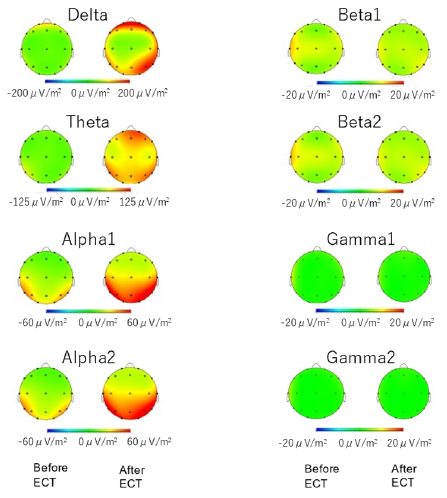
Figure 2. Grand average topographical plot of electroencephalography power in delta, theta, alpha 1, alpha 2, beta 1, beta 2, gamma 1, and gamma 2 for both time points (before and after electroconvulsive therapy (ECT)). In alpha 1 and alpha 2, the electrodes O1, O2, P3, P4, T5, T6, and Pz were selected to average the spectral power. In other ranges, all electrodes were selected to average the